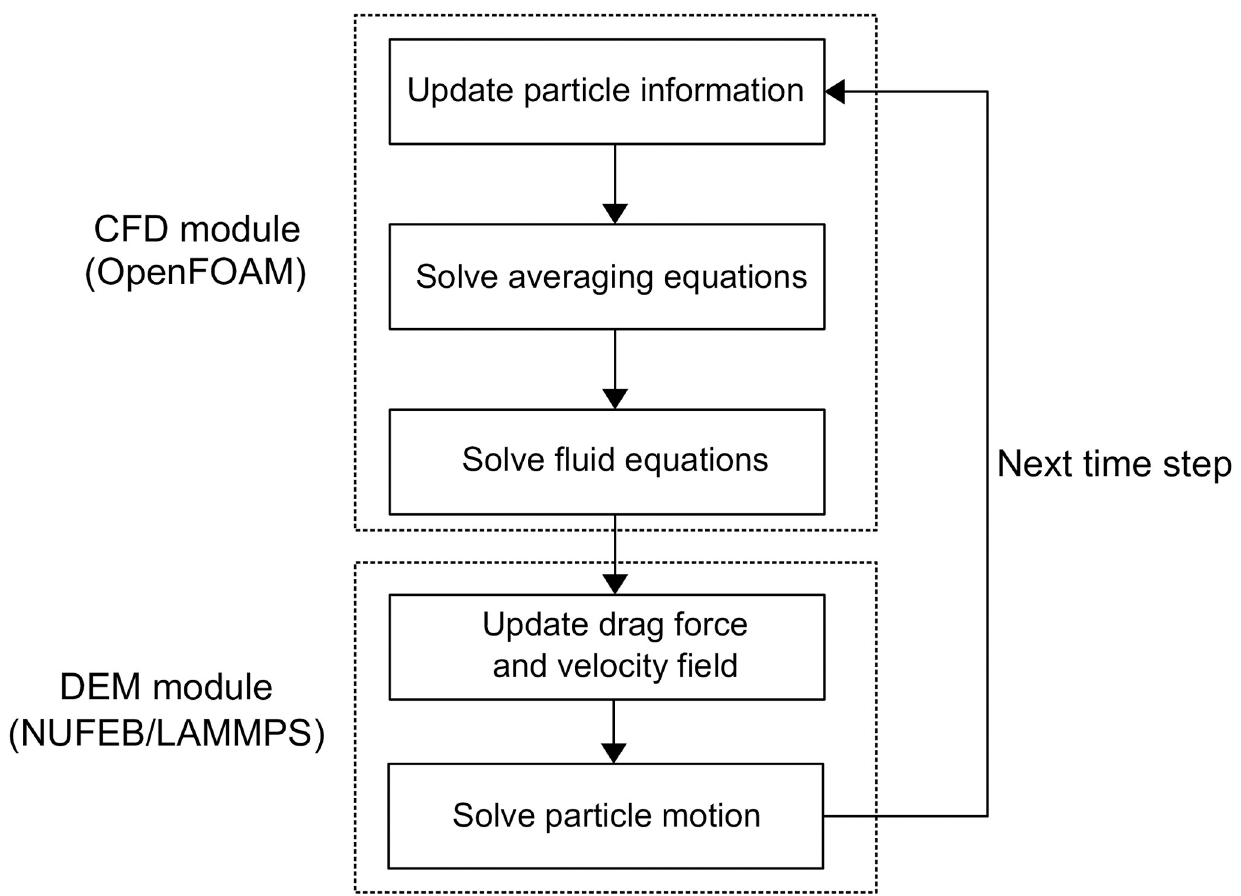
Fig 3. Block diagram of CFD-DEM coupling. Diagram adopted from [39]. Fluid dynamics is solved in the CFD module and particle motion is solved in the DEM module. Particle and field information are transferred between the two modules based on an averaging procedure.